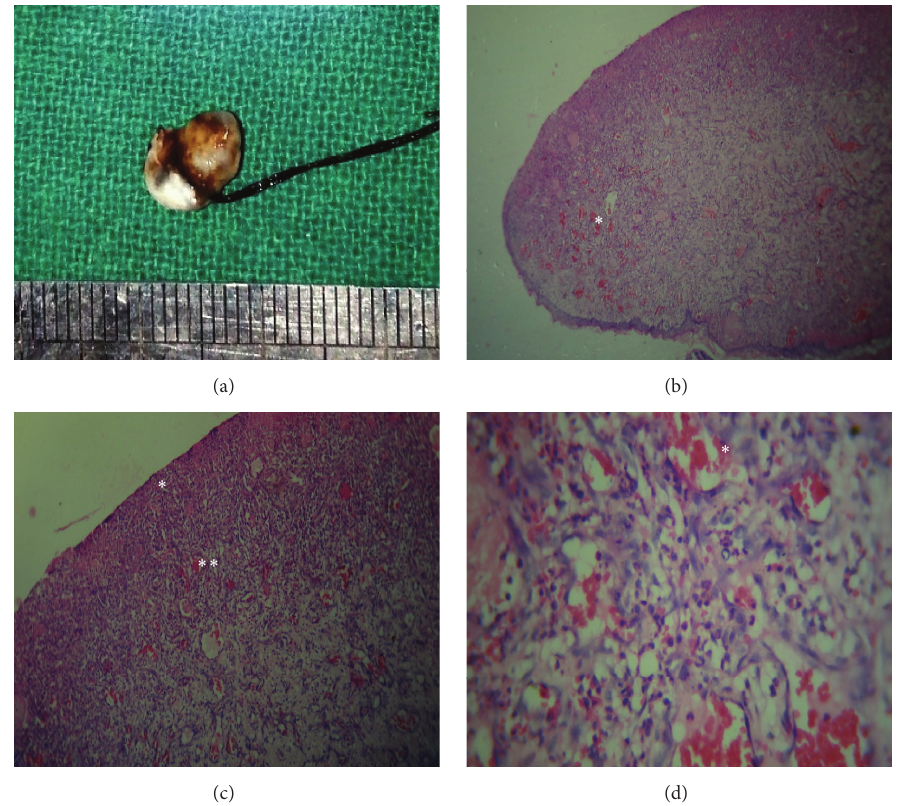
Figure 3: Case 3 description: (a) gross specimen; (b) scanning power view showing numerous endothelial cell lined proliferating capillaries and dense inflammatory cell infiltration ( ∗ ) (H&E, 50x); (c) low power view showing fibrinopurulent membrane ( ∗ ) and underlying stroma showing numerous endothelial cell lined capillaries ( ∗∗ ) (H&E, 400x); (d) high power view showing numerous endothelial cell lined vascular spaces engorged with red blood cells ( ∗ ) (H&E,